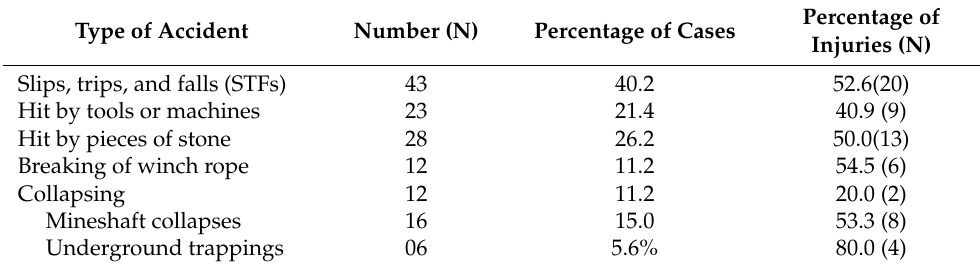
Table 2. Reported types of accidents and associated occurrences of